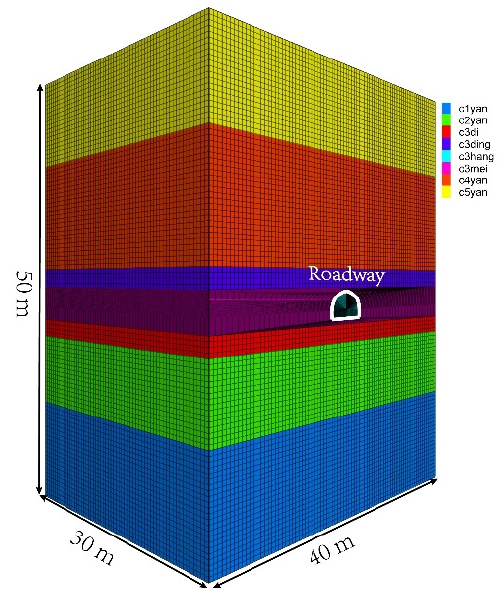
Figure 18. Geometric model of transportation roadway in 2233 working face. The displacement was fixed around and at the bottom of the model, and a static load of 20 MPa was applied at the top to simulate the overburden weight. The model was divided into five layers. The NFNVRM constitutive model was used to study the influence of creep characteristics on the deformation of the roadway and its rock. The Mohr–Coulomb constitutive model was used for the remaining layers to restore the surrounding rock properties of the roadway as much as possible. Through field investigation and sampling, the property parameters of the coal and adjacent rock layers were obtained, as shown in Table